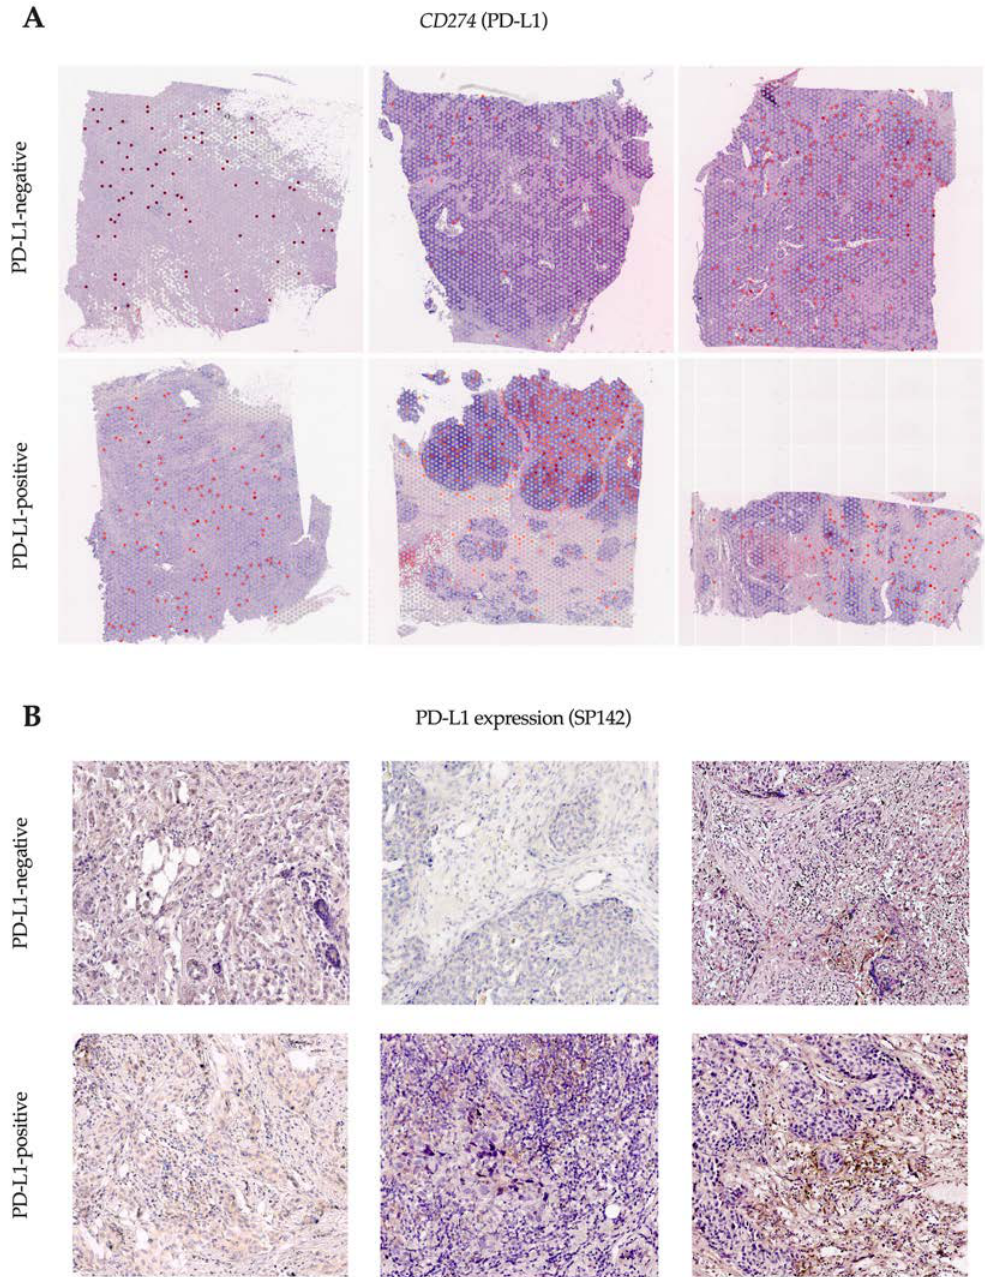
Figure 1. Visium 10x spatial transcriptomic analysis of breast cancer. CD274 expression in spots indicated as red dots in PD-L1-negative and PD-L1-positive patients ( A ); PD-L1 expression on immune cells (ICs) was assessed by SP142 immunohistochemistry assay in corresponding tissue samples of each patient ( B ). Magnification 200×.